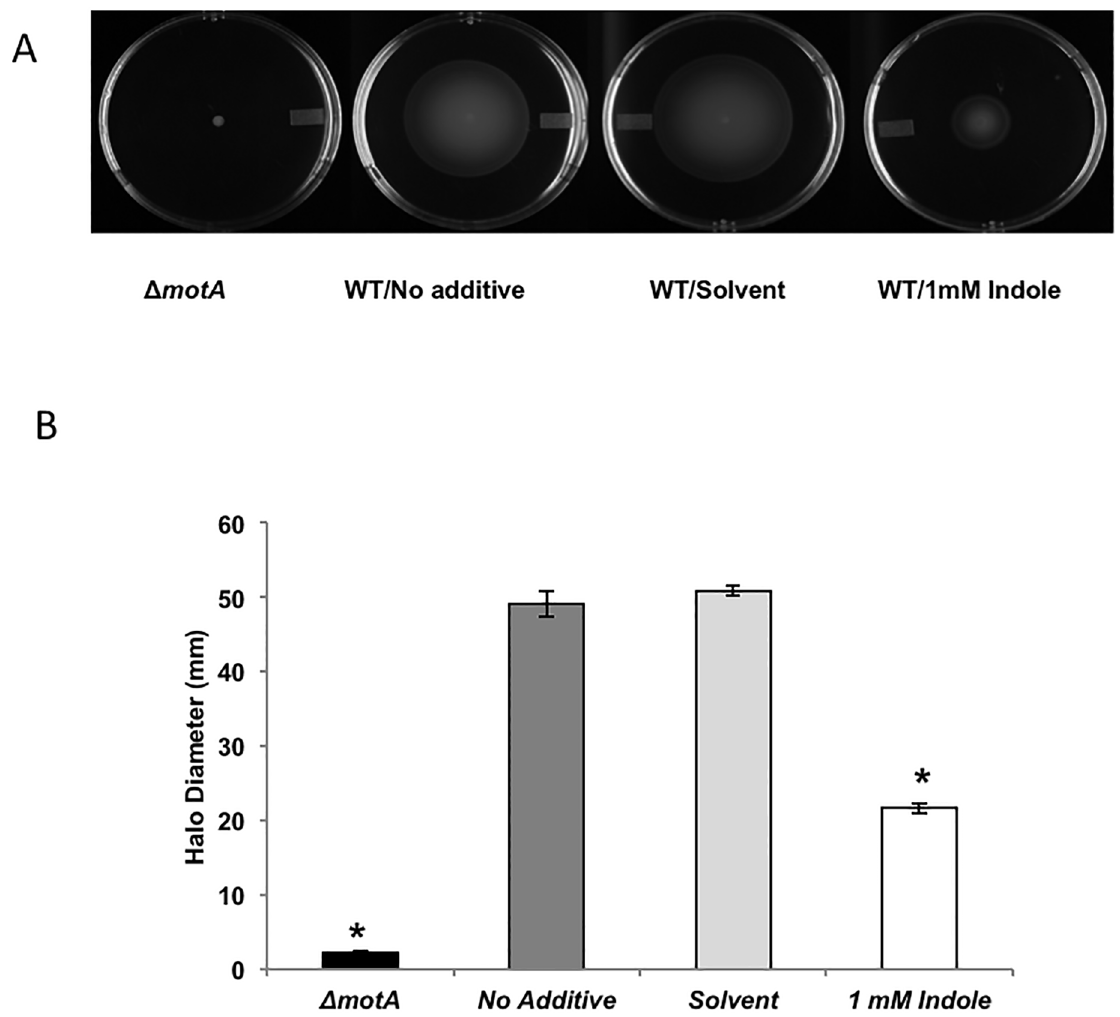
Fig 2. Effect of indole on Salmonella swimming motility at 37˚C. (A) Representative photographs of the swimming motility agar plates spotted with WT Salmonella . (B) Measured halo diameters for the different test conditions. Diameters were measured using Vernier calipers, 8 hours post spotting. Δ motA was spotted on swimming motility agar plates as a negative control for motility. (cid:3) denotes statistical significance relative to the solvent control at p < 0.05 using the Student’s t -test. Column bars depict mean (n = 4) and error bars represent standard deviation